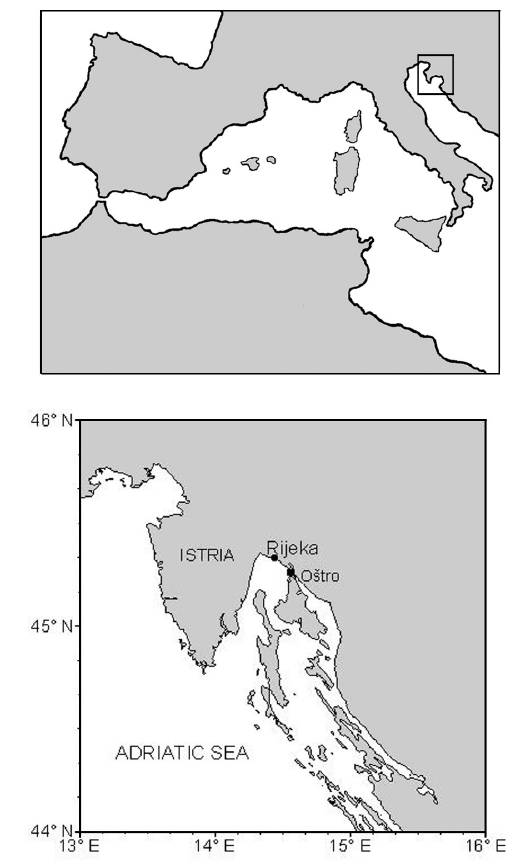
Fig. 1. – Map of the western Mediterranean and Adriatic Sea show- ing the Kvarner area and a detail map of the Kvarner area with the sampling location of Buenia affinis at